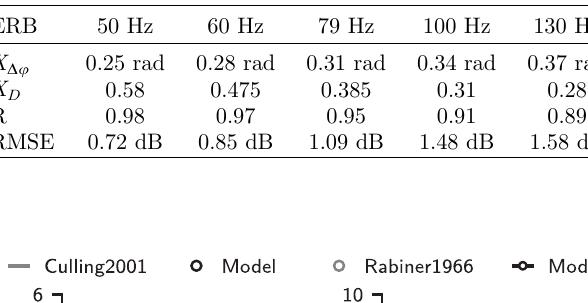
Table 1. Internal noise parameters, R 2 correlation between the 24 experimental and simulated N s S p thresholds and root-mean- square error (RMSE) for the fi ve different fi lter bandwidths.